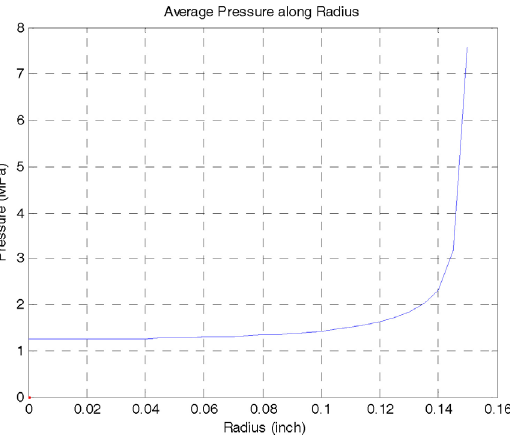
Fig. 6 Normal stress along radius direction (chamfer angle = 20  ).